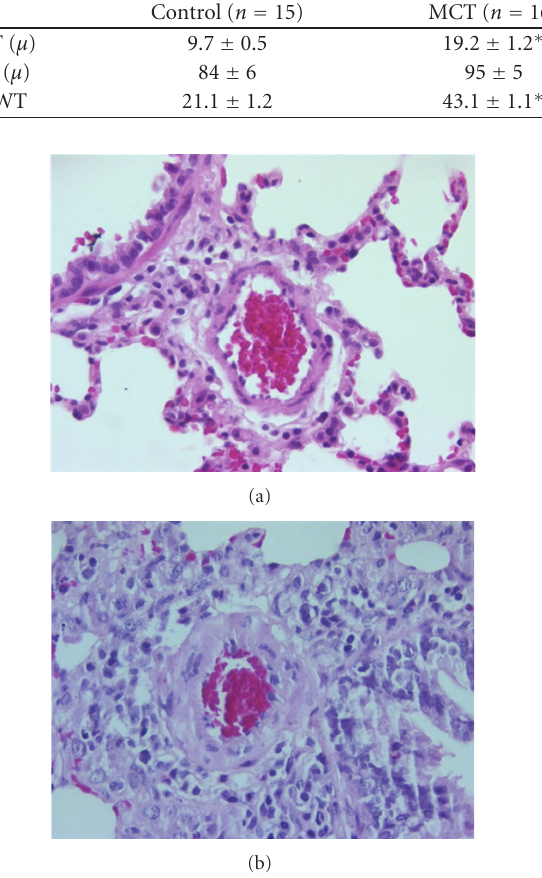
Figure 1: Pulmonary arteries were demonstrated in lungs from control group (a) and from the rat with monocrotaline-induced pulmonary hypertension